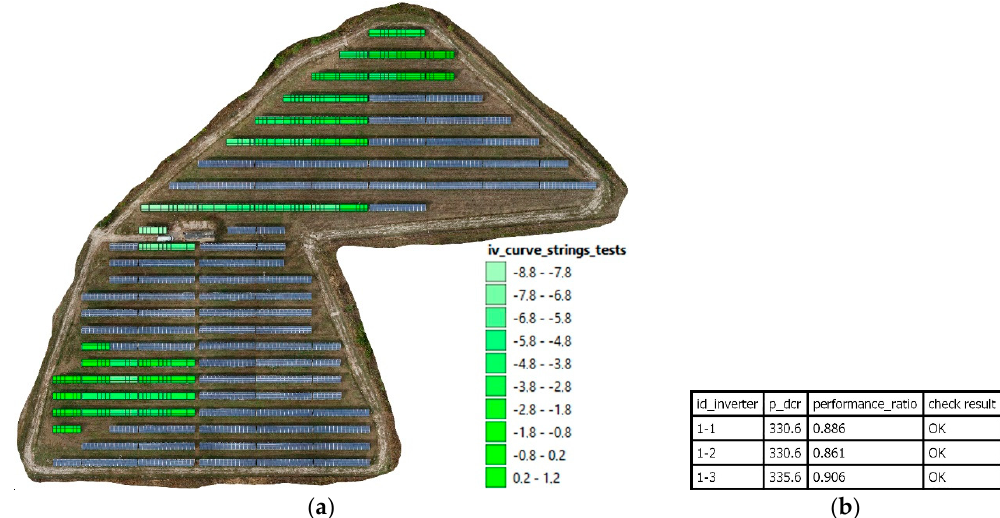
Figure 18. (Plant B) ( a ) The customized map of a PV system to show the results of the I–V curve tests. ( b ) The table with the results of the performance ratio check.